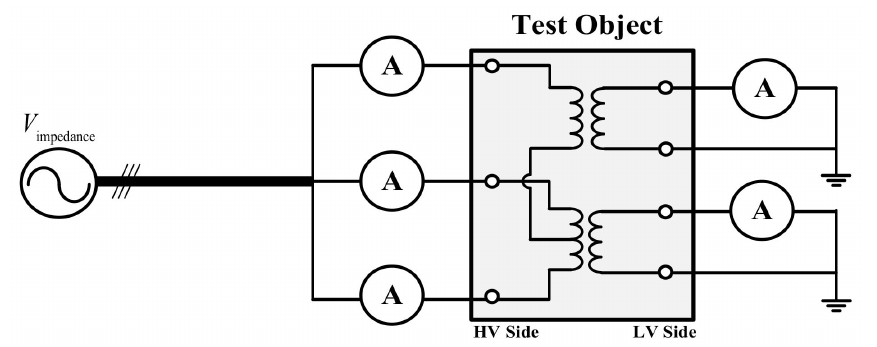
Figure 10. An equivalent circuit diagram for impedance voltage